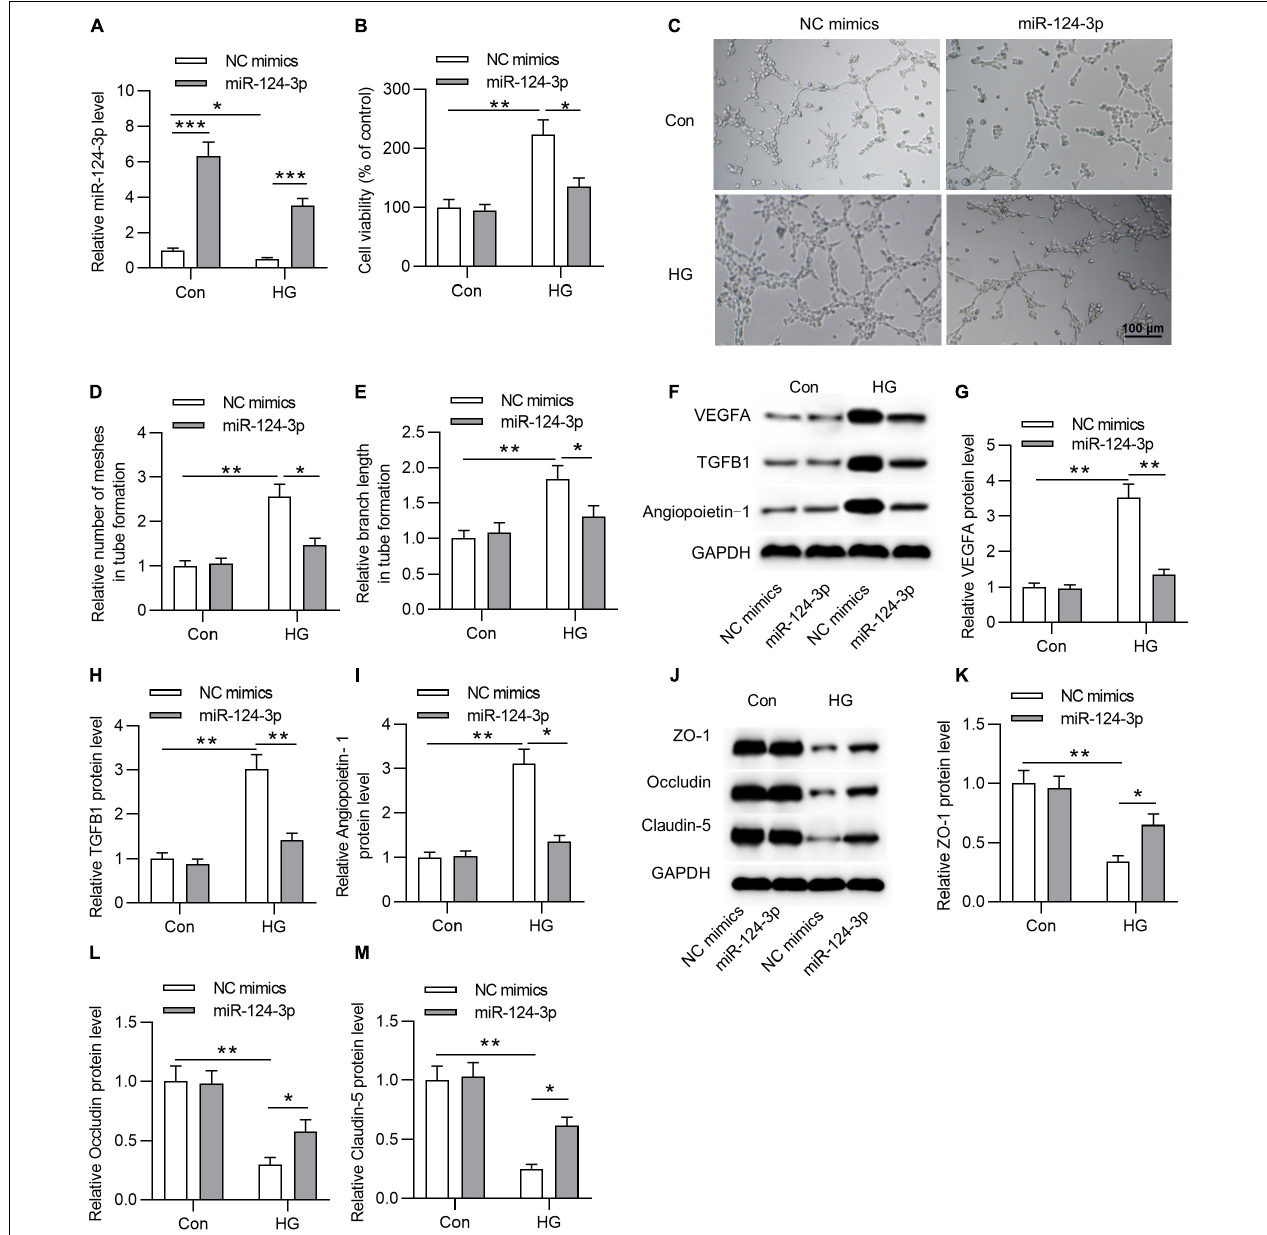
FIGURE 2 | MiR-124-3p overexpression restrained HG-induced cell injury of HRMECs. (A) The overexpression efficiency of miR-124-3p mediated by transfection of miR-124-3p mimics for 24 h in HRMECs was assessed by RT-qPCR analysis. (B) The effect of miR-124-3p overexpression on the viability of HRMECs in the control group (5 mM glucose) and HG group (30 mM glucose) was evaluated by CCK-8 assay. (C–E) The mesh number and branch length of HRMECs upon the introduction of HG (30 mM glucose) for 48 h was detected by the tube formation assay. (F–I) Western blot analysis measured the levels of proteins associated with angiogenesis (VEGFA, TGFB1 and Angiopoietin-1) in NG (5 mM glucose) or HG (30 mM glucose)-stimulated HRMECs followed by the transfection of miR-124-3p mimics for 24 h. (J–M) The levels of proteins associated with blood-ocular barrier (ZO-1, Occludin and Claudin-5) in NG (5 mM glucose) or HG (30 mM glucose)-stimulated HRMECs followed by the transfection of miR-124-3p mimics for 24 h were analyzed by western blot analysis. * P < 0.05, ** P < 0.01, *** P <